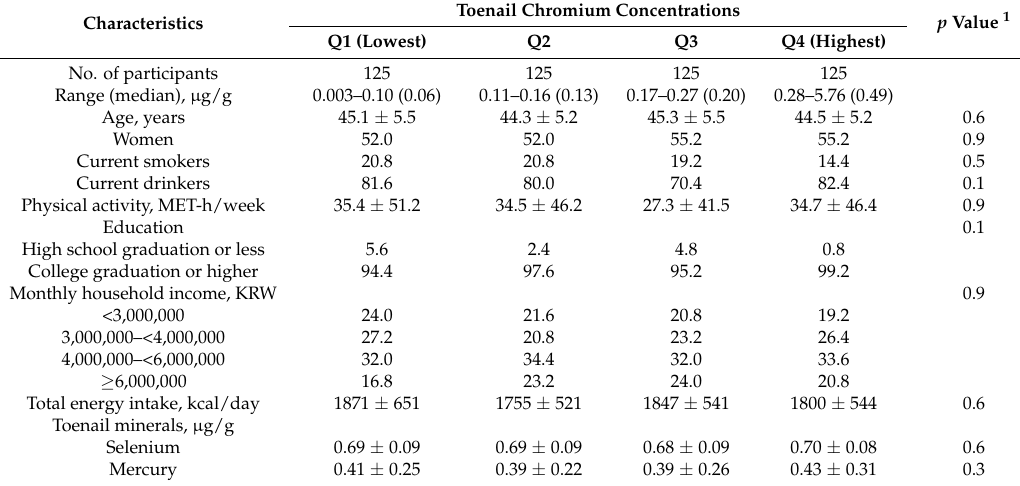
Table 1. Characteristics of participants according to quartiles of toenail chromium concentrations, the SELEN study ( n =